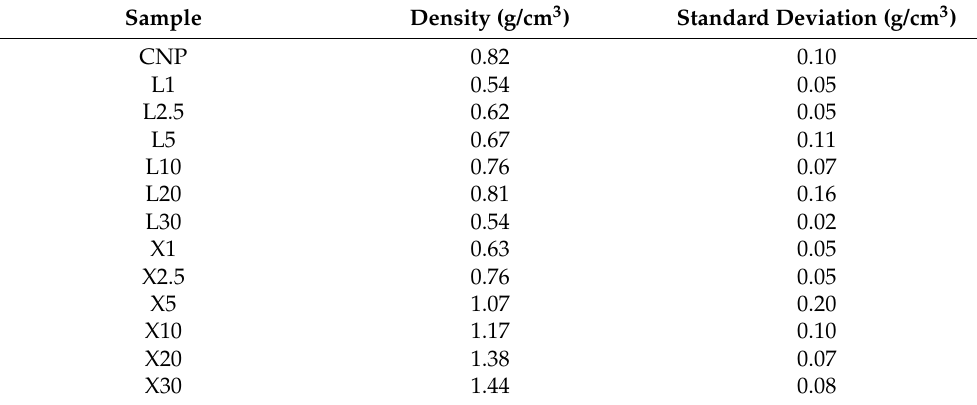
Table 3. Densities of prepared